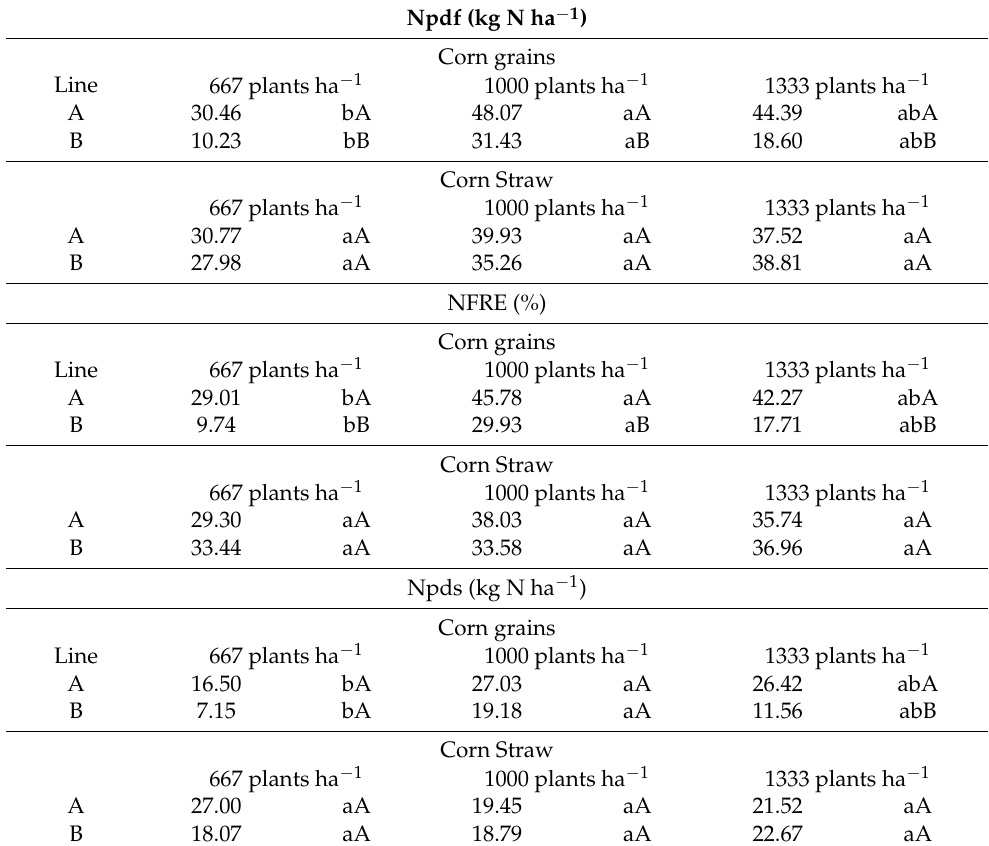
Table 1. Nitrogen in plant derived from fertilizer (Npdf), N fertilizer recovery efficiency (NFRE) and N in plant derived from soil (Npds) in corn grains and straws under agrisilvicultural system with 667, 1000 and 1333 plants of Gliricidia sepium ha − 1 . Corn plants were collected at lines close to the G. sepium plants (A) and in the middle of the plots—middle of the alleys